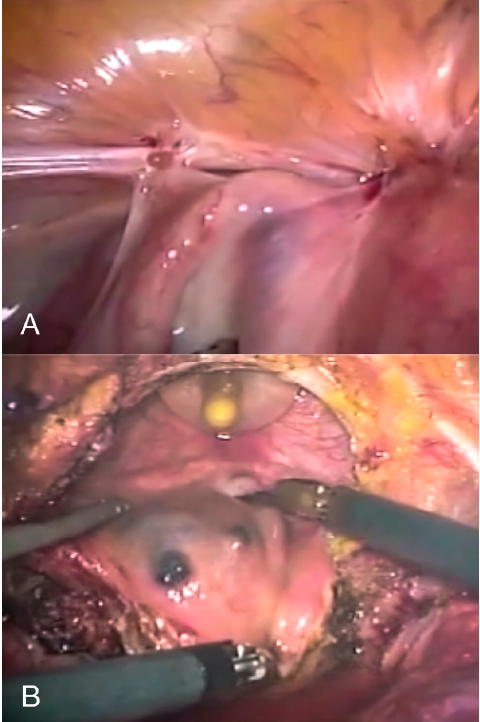
Figure 7. Laparoscopic depiction of bladder deep endometriosis ( A ) before and ( B ) during full- thickness